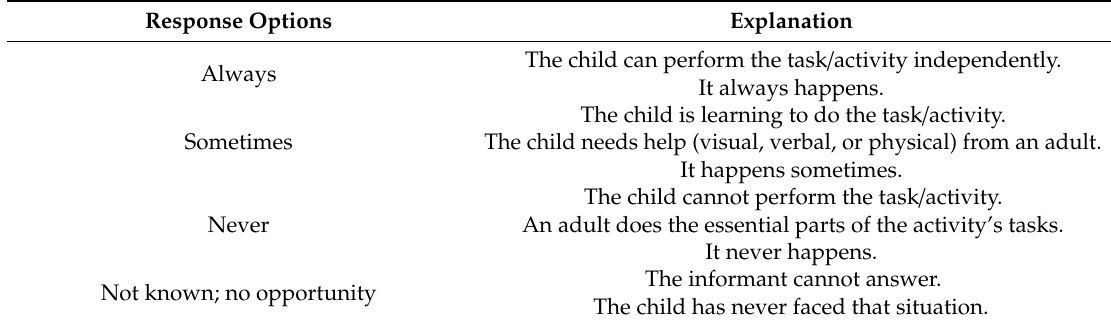
Table 4. Activities of Daily Living Evaluation in Schoolchildren (ADL-E) response options.